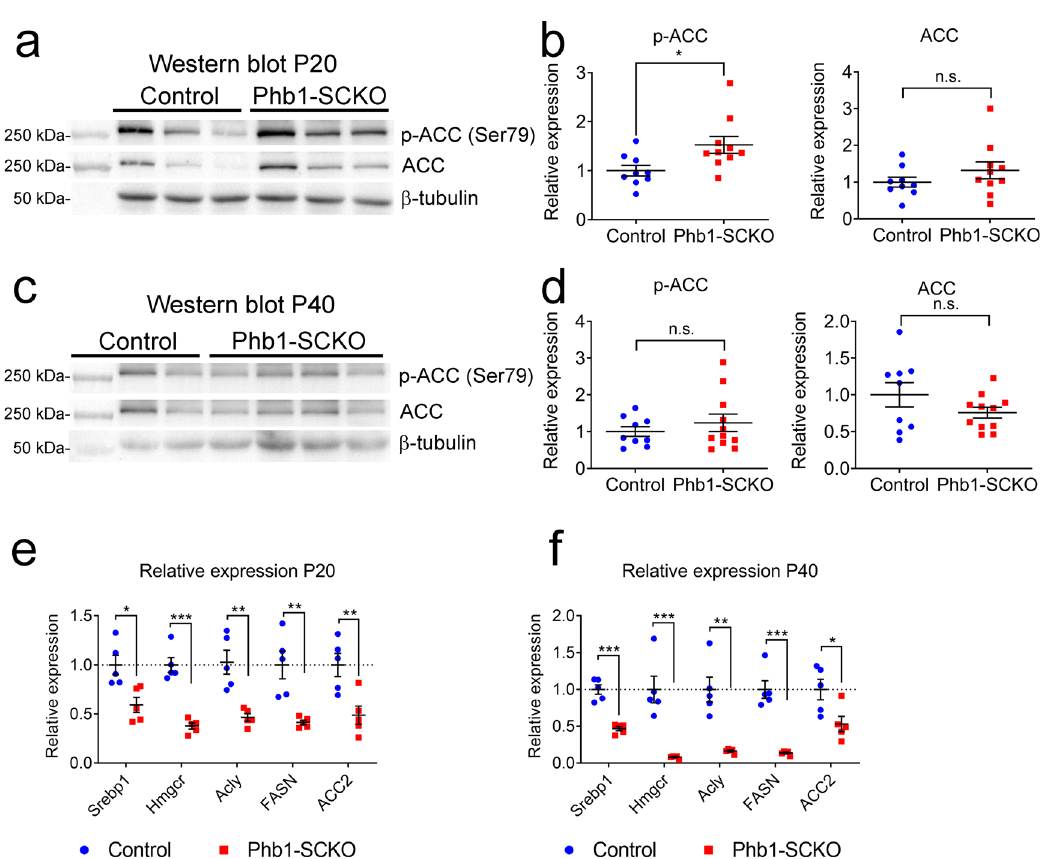
Fig. 6 Deletion of Phb1 affects lipid metabolism. Western blot ( a ) and quanti fi cation ( b ) of Acetyl-CoA carboxylase (ACC) and phosphorylated ACC (p-ACC) expression at P20. N = 6 – 7 animals per genotype. Unpaired two-tailed t -test [p-ACC ( t = 0.4627, df = 11, p = 0.021), ACC ( t = 1.355, df = 11, p = 0.26)]. Western blot ( c ) and quanti fi cation ( d ) of ACC and p-ACC expression at P40. N = 6 – 8 animals per genotype [p-ACC ( t = 0.5447, df = 12, p = 0.42), ACC ( t = 1.153, df = 12, p = 0.17)]. Unpaired two-tailed t -test. By RT-qPCR, we identi fi ed a signi fi cant downregulation of many enzymes involved with lipid biosynthesis at both P20 ( e ) and P40 ( f ): sterol regulatory element-binding protein 1 ( Srebp1 ), 3-hydroxy-3-methylglutaryl-CoA reductase ( Hmgcr ), ATP citrate lyase ( Acly ), fatty acid synthase ( FASN ), acetyl-CoA carboxylase 2 ( ACC2 ), N = 5 animals per genotype. Unpaired two-tailed t -test P20 [ Srebp1 ( t = 3.26, df = 8, p = 0.012), Hmgcr ( t = 7.63, df = 8, p = 0.000061), Acly ( t = 4.418, df = 8, 0.0022), FASN ( t = 4.109, df = 8, p = 0.0034), ACC2 ( t = 3.408, df = 8, p = 0.0092)]; P40 [ Srebp1 ( t = 7.551, df = 8, p = 0.000066), Hmgcr ( t = 5.091, df = 8, p = 0.00094), Acly ( t = 4.934, df = 8, p = 0.0011), FASN ( t = 7.186, df = 8, p = 0.000094), ACC2 ( t = 2.697, df = 8, p = 0.027)]. Data are presented as mean ± SEM. * p < 0.05; ** p <